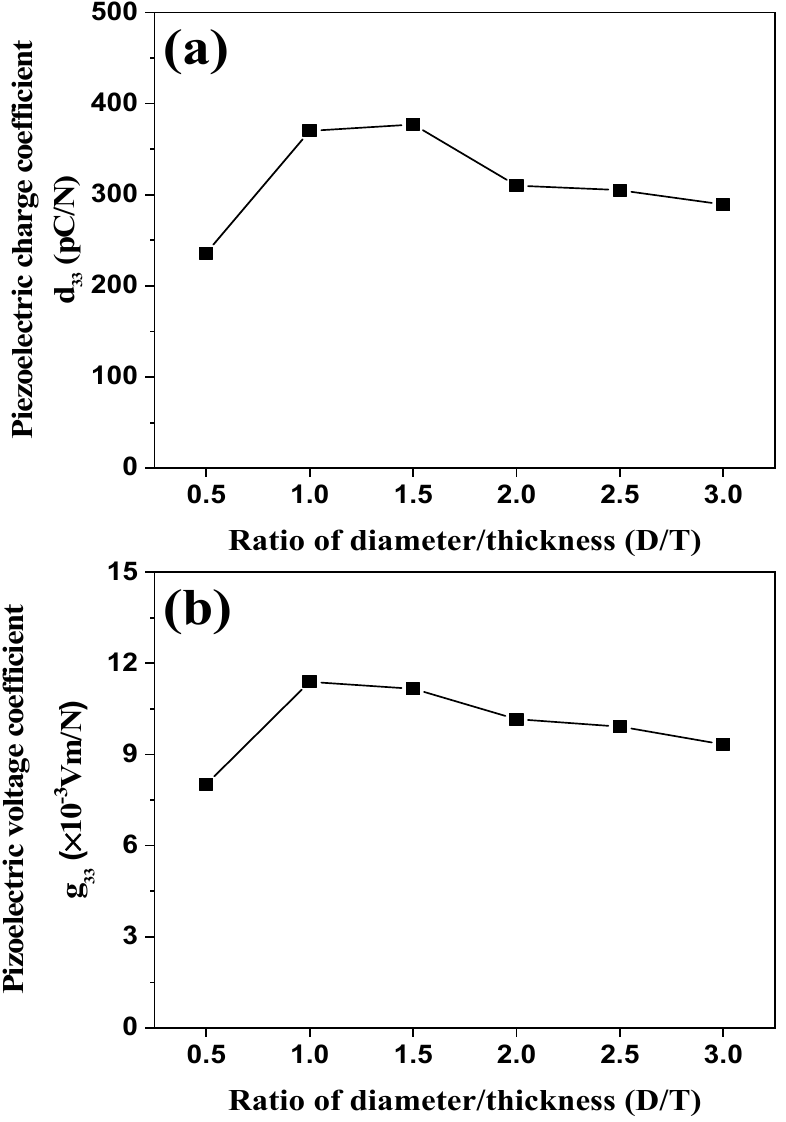
Figure 6. ( a ) Piezoelectric charge coefficient and ( b ) piezoelectric voltage coefficient of BZT–BCT ceramics vs. the D/T ratio.